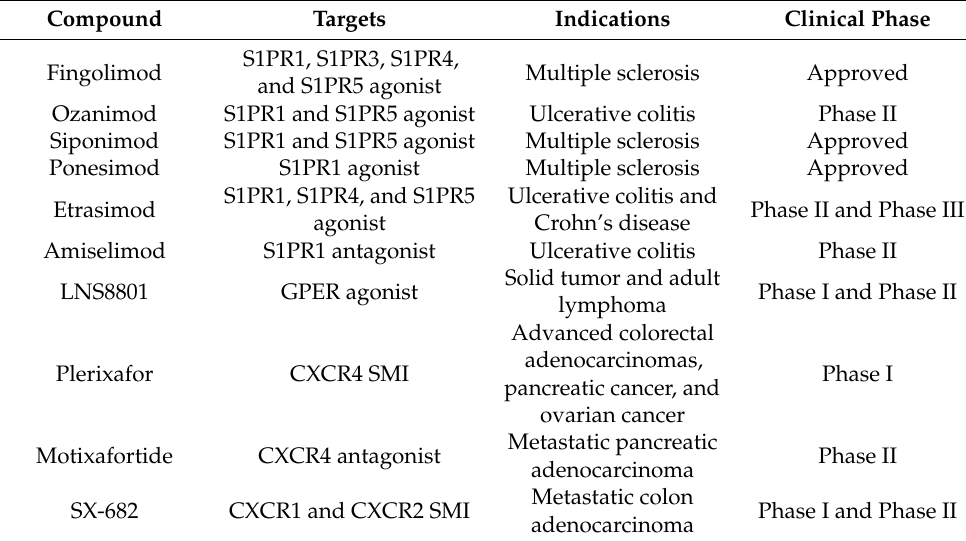
Table 4. List of drug candidates targeting